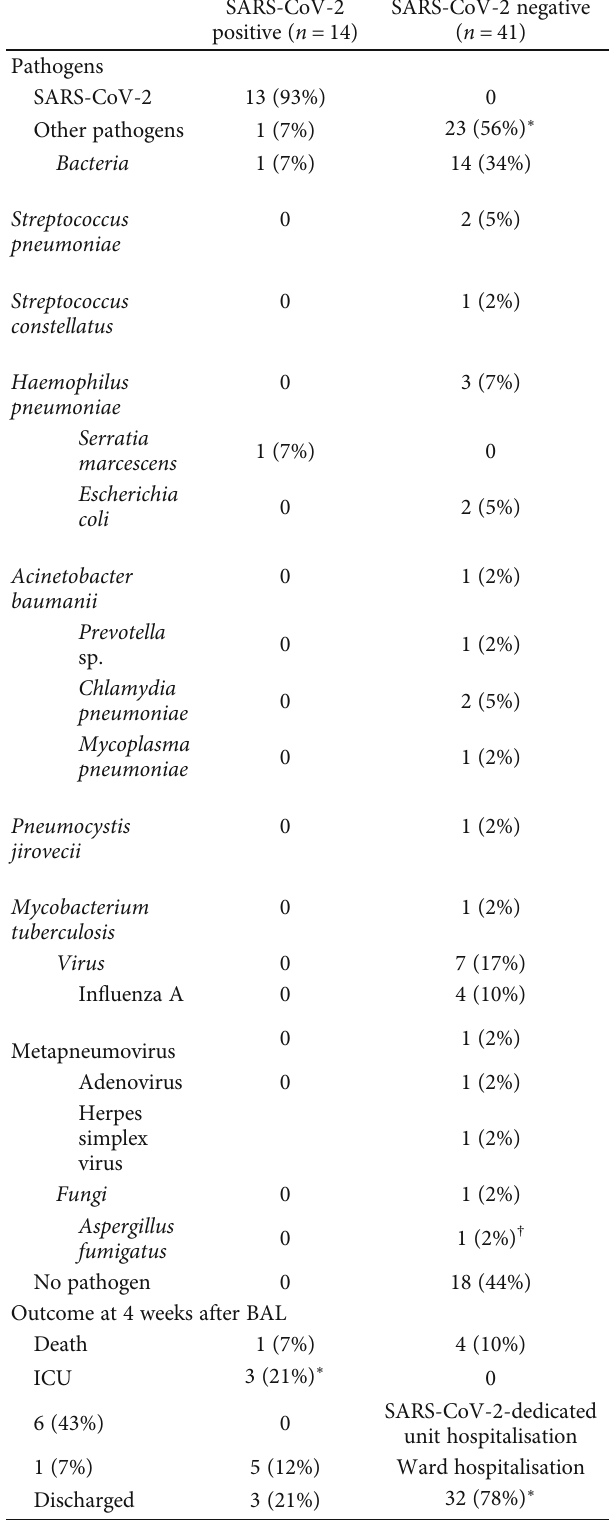
Table 2: Bronchoalveolar lavage